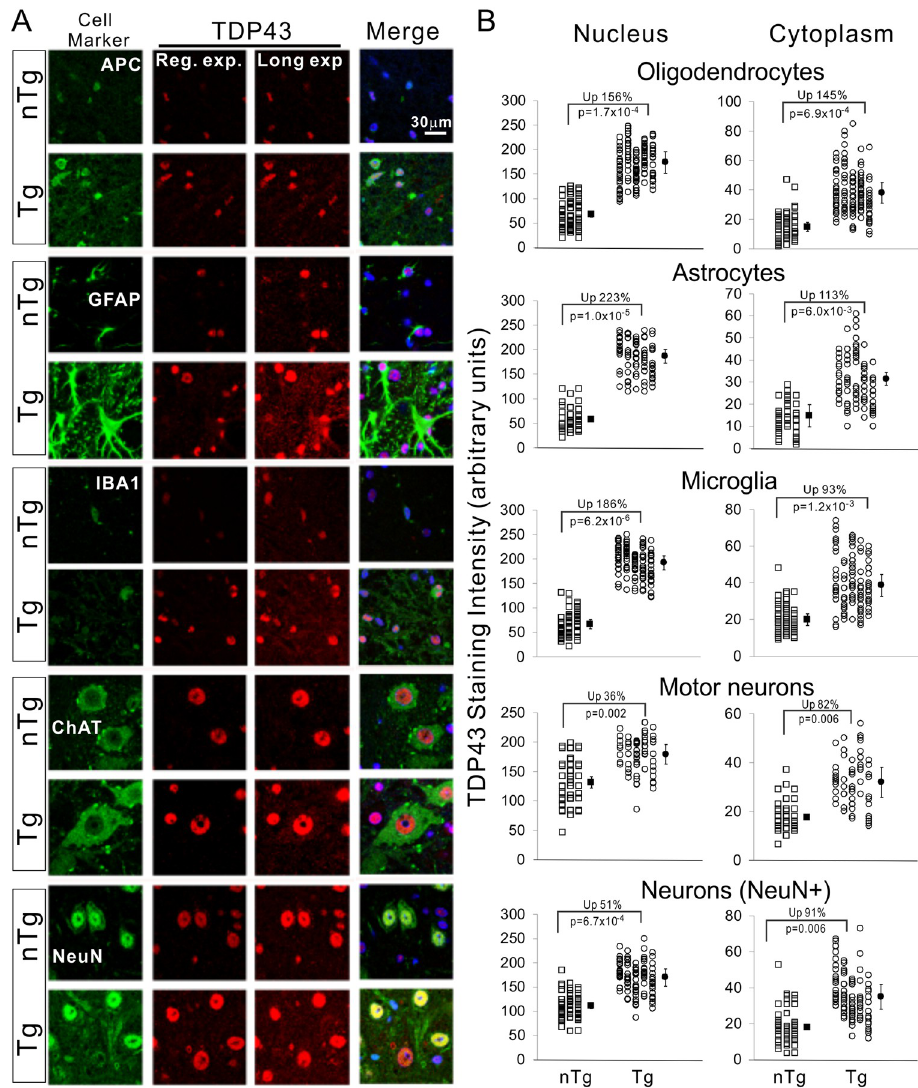
Fig 4. TDP-43 distribution in glial cells and neurons. (A) Mouse spinal cords were immuno-stained with cellular markers for oligodendrocytes (APC), astrocytes (GFAP), microglia (IBA1), motor neurons (ChAT), and pan neurons (NeuN). For TDP-43 staining, images of both regular (Reg.) and long-exposure (Long exp.) are shown. The long- exposure images were used to visualize the cytoplasmic signal and quantify TDP-43 staining intensity in the cytoplasm. All images are in the same magnification. (B) Quantification of staining intensity of TDP-43 in the nucleus and cytoplasm of various cell types show in (A). Each symbol represents measurement from one cell. Each column of symbols represents measurements from one mouse. The filled symbols represent averages for each genotype. The changes of averages in percentage in the Tg mice and the statistical p values are shown on the graphs. Student’s t test is used to obtain the p values. n = 3 for nTg and 5 for Tg mice,